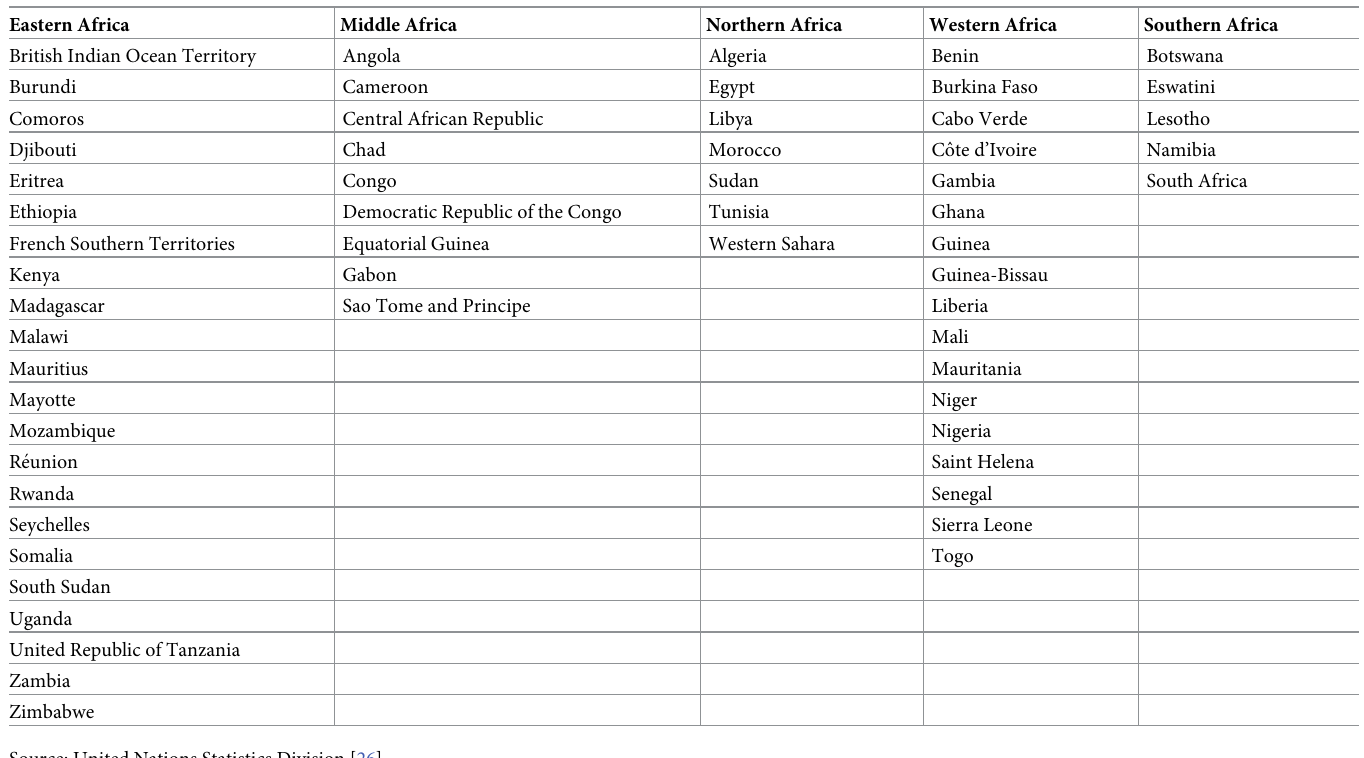
Table 1. United Nations categorization of countries in the African